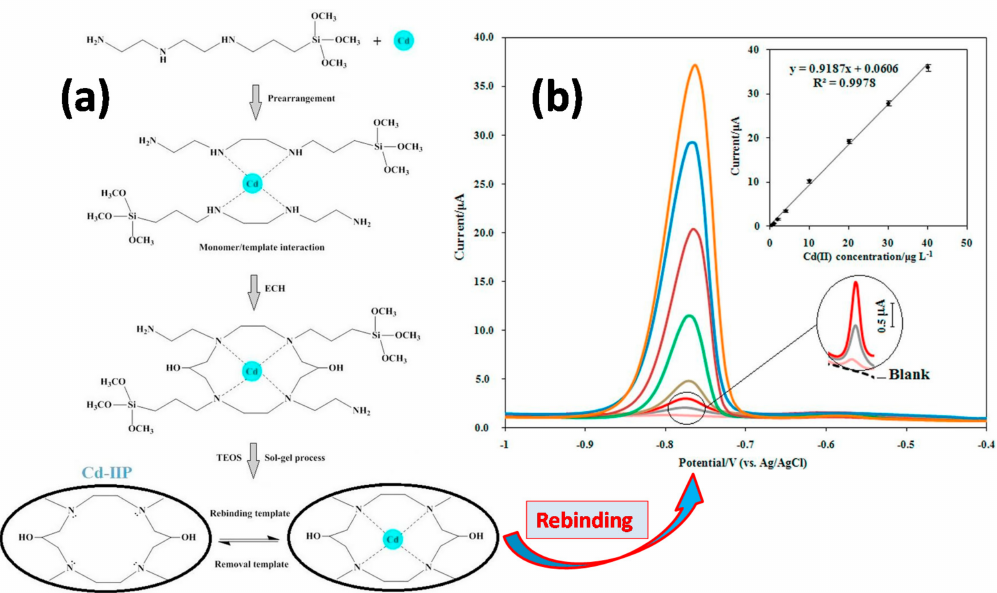
Figure 18. Synthesis of a cadmium ion imprinted sol-gel ( a ), and the use of its corresponding carbon paste for the highly sensitive detection of Cd(II). ( b ) Square wave voltammograms of Cu(II) detection and its further calibration curve. Reproduced with permission of Elsevier from [129].